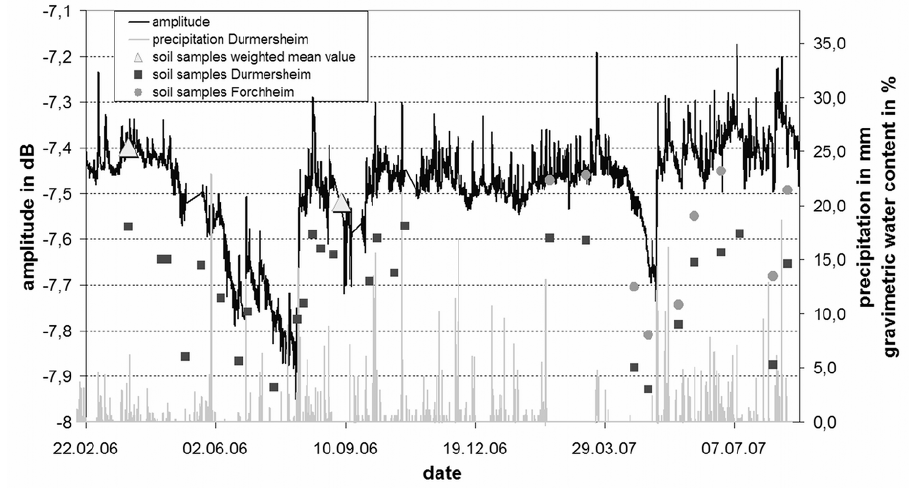
Figure 16 . Amplitude of the reflected signal and SM at two sites below the power line. The weighted mean values (triangles) of SM taken along the complete transect are